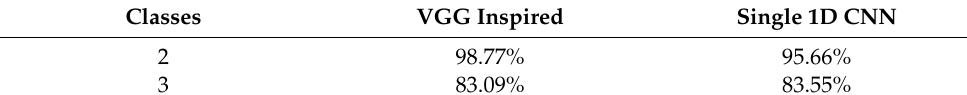
Table 5. Test set accuracy for each stress-classification task and architecture.